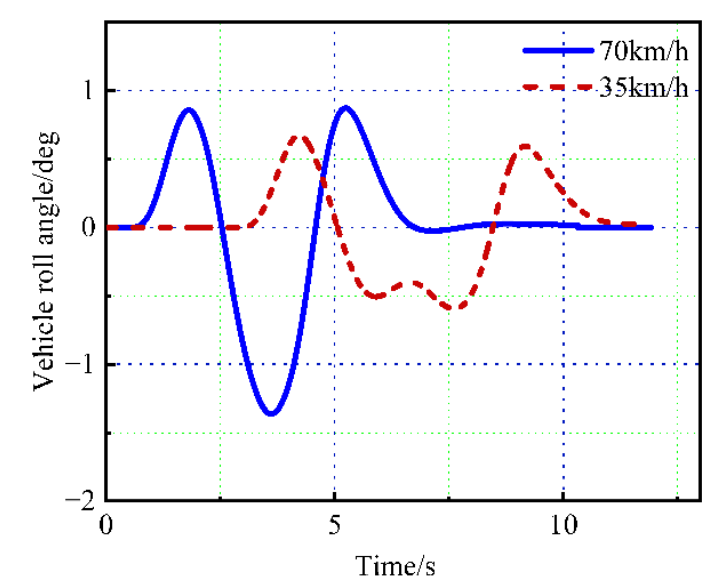
Figure 13. Change curve of vehicle roll angle.